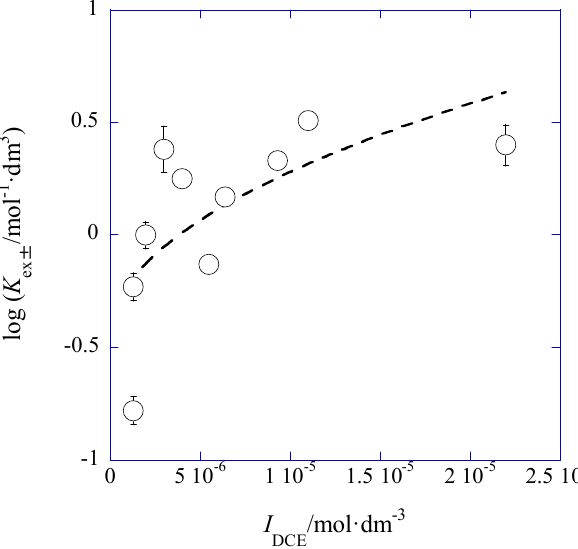
Figure 6. A plot of log K ex± vs. I for the AgPic extraction with B18C6 into DCE. The regression line (broken line) based on the Davies equation was log K ex± = 0.596 – 2 × 2.05 {√(cid:1835)/(1 + √(cid:1835)) − 0.3(cid:1835)} at r = 0.884 and N = 10. Inorganics 2017, 5 , 42